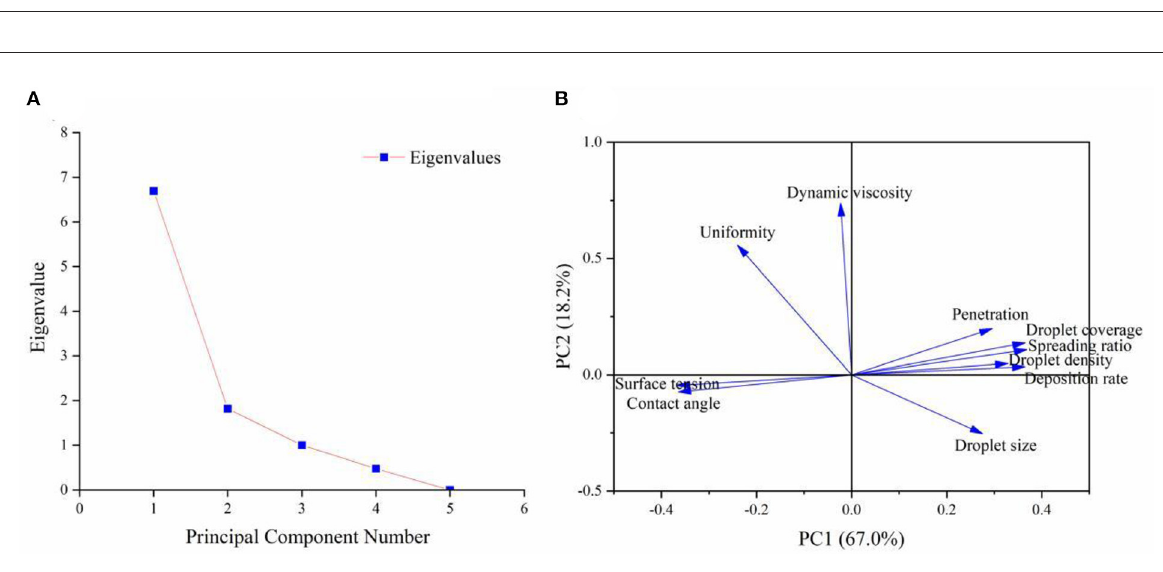
FIGURE10 Scree plot of eigenvalues for principal components (A) and loading plot for principal components 1 and 2 (B)